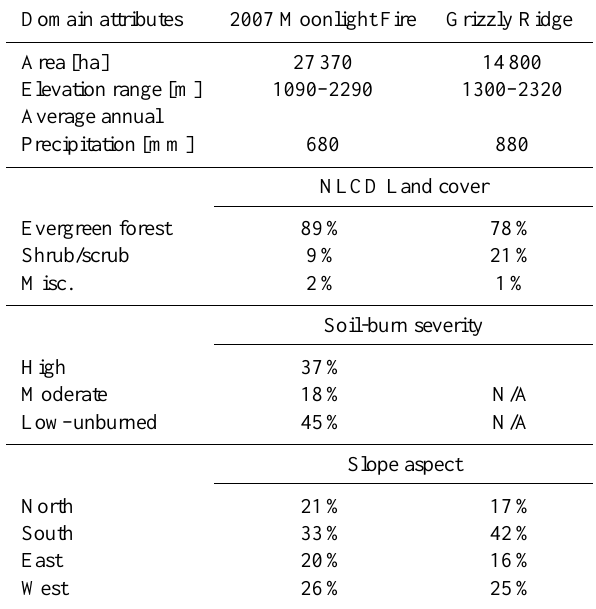
Table 1. Domain attributes for the Moonlight Fire and Grizzly